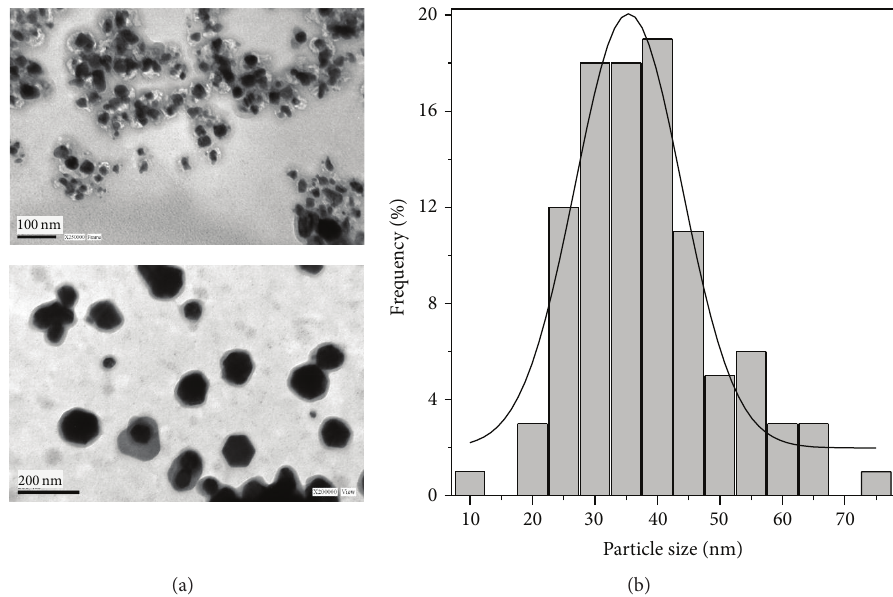
Figure 3: (a) Representative TEM images of Ag-NPs biosynthesized by reducing Ag + ions using a culture supernatant of P. aeruginosa . (b) Particle size histogram of Ag-NPs from TEM image showing the distribution of nanoparticles.